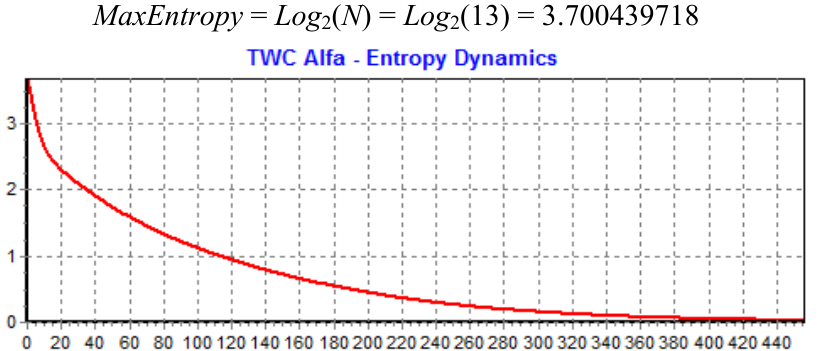
Figure 11. The decreasing of Entropy during the search of TWC ( α ).